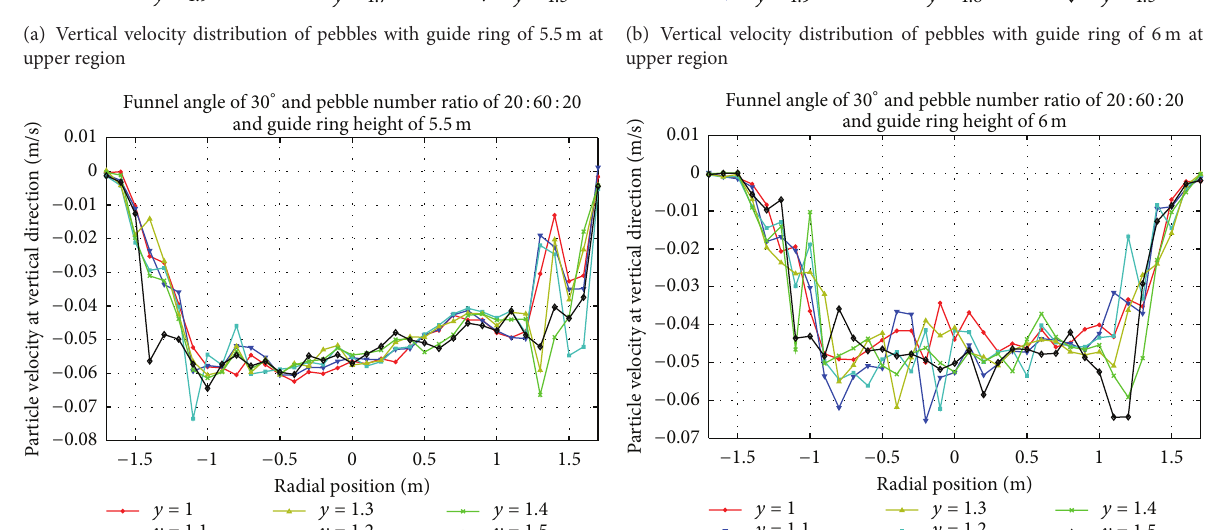
(a) Vertical velocity distribution of pebbles with guide ring of 5.5m at upper region